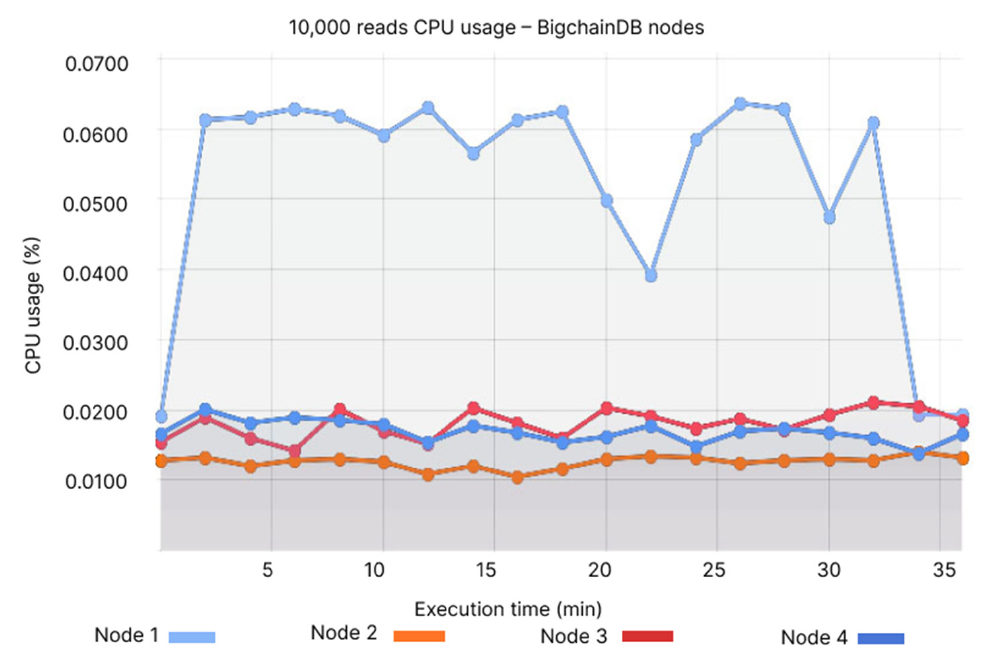
Figure 26. 10,000 reads CPU usage—BigchainDB nodes.